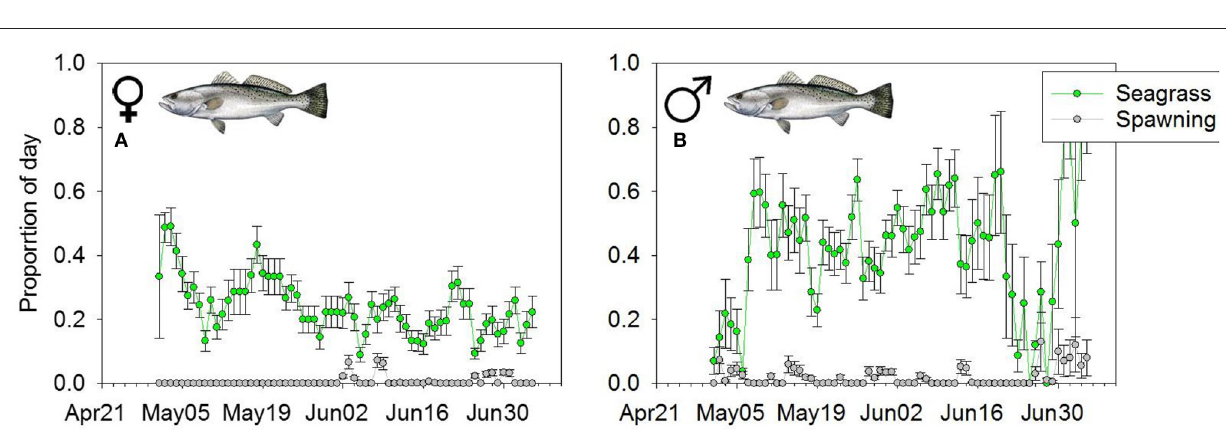
FIGURE 4 | Mean daily proportion use of (A) female and (B) male Snook of the spawning (gray line) or foraging (green line) habitat. Error bars represent (1 ± SE).